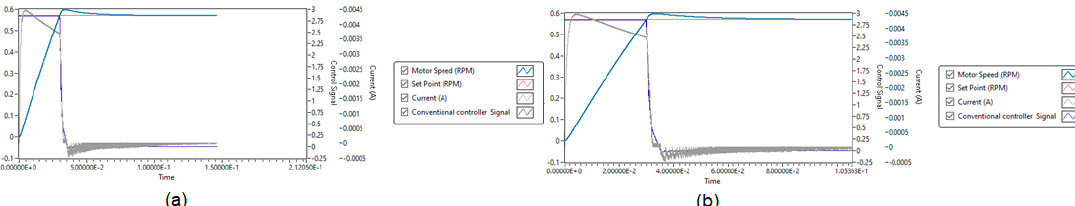
Figure 7. Block diagram of the experimental setup.